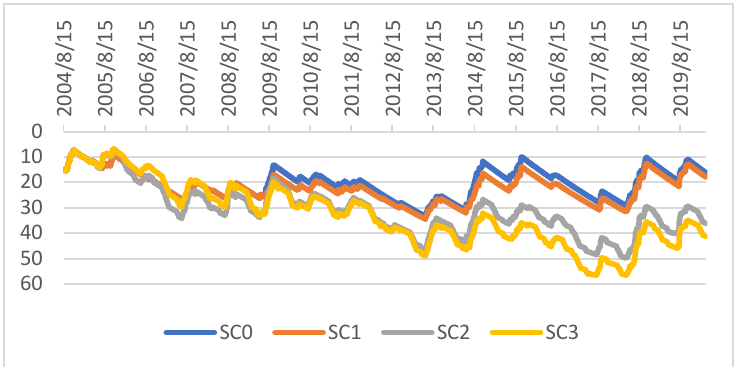
Figure 6. Evolution of the water table depth depending on the four scenarios of farming practices.